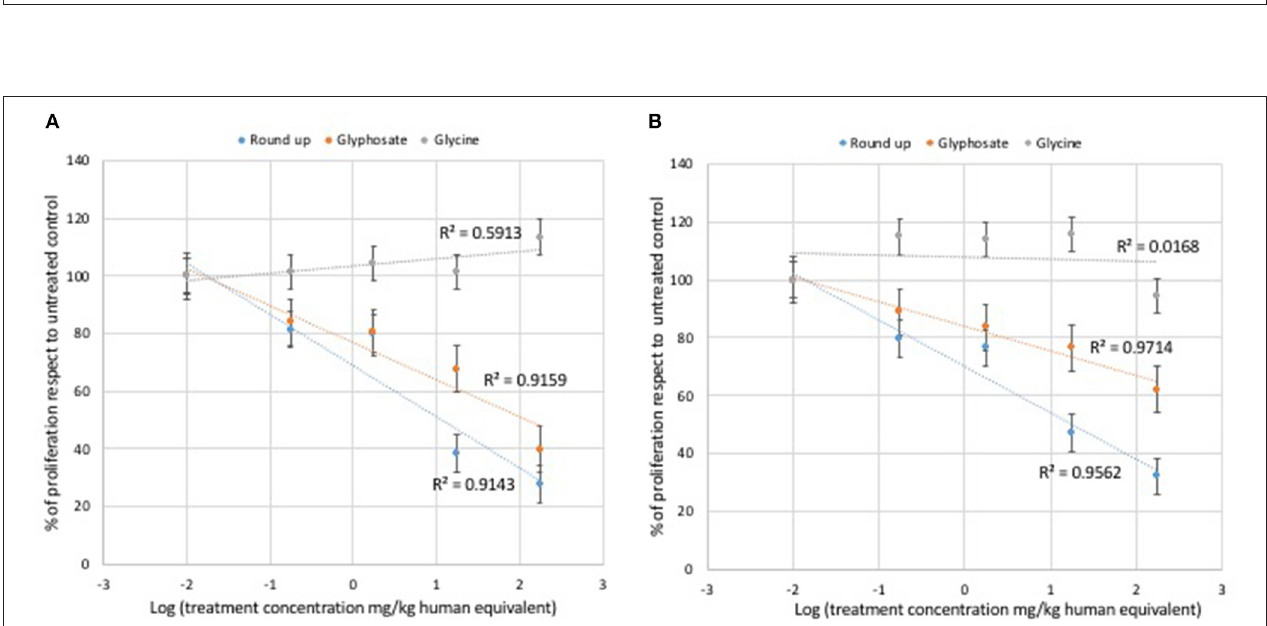
FIGURE 2 | Relationship between pure glyphosate, Roundup Bioflow, and glycine at the dose range 0–175mg kg − 1 (human equivalent) (Log scale) and cell proliferation of L929 fibroblasts (A) and Caco2 cells (B) . Data are expressed as mean value ( ± st. dev.) (% compared to control). R 2 , coefficient of determination.